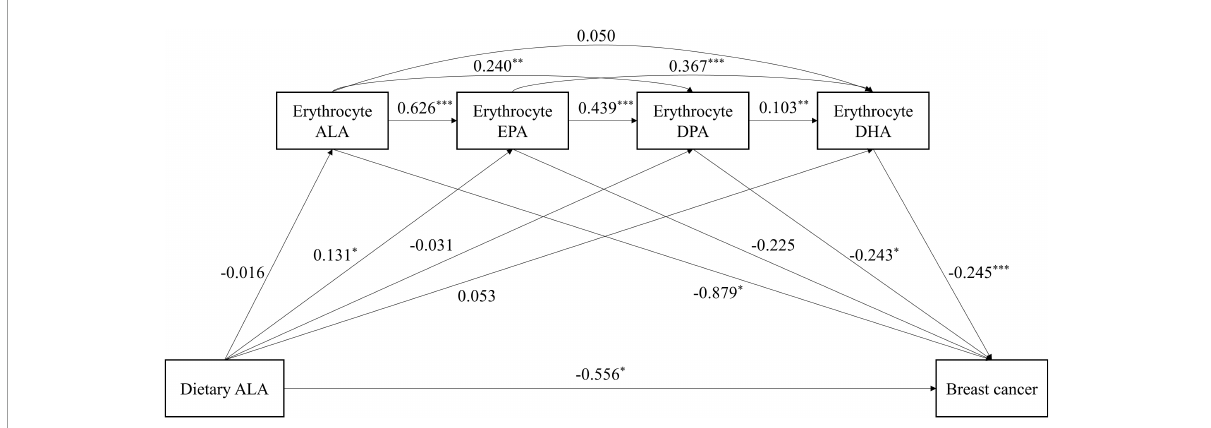
FIGURE1 The chain mediating effect of erythrocyte n – 3 PUFAs on the relationship between dietary ALA intake and breast cancer risk. ALA, α -linolenic acid; DHA, docosahexaenoic acid; DPA, docosapentaenoic acid; EPA, eicosapentaenoic acid; PUFA, polyunsaturated fatty acid. Standardized estimating of 5,000 bootstrap sample. Age, BMI, MET-h/week, education, passive smoking, regular drinking, first-degree relatives with cancer and energy intake were controlled. ∗∗∗ P < 0.001, ∗∗ P < 0.01, ∗ P <